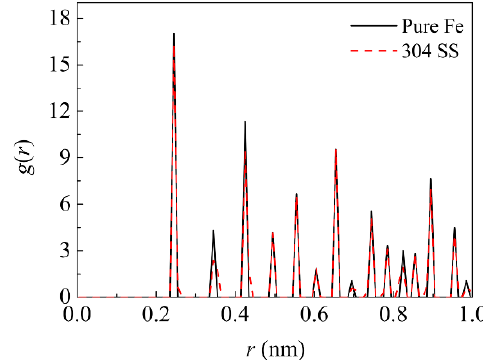
Figure 2. Comparison of radial distribution function (RDF) between the pure Fe and 304 stainless steel (304 SS).